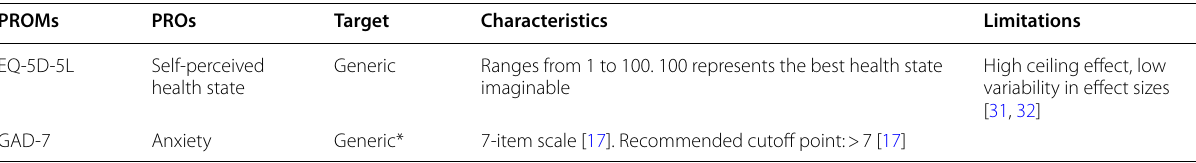
Table 2 CEP generic PROMs, these are also available as